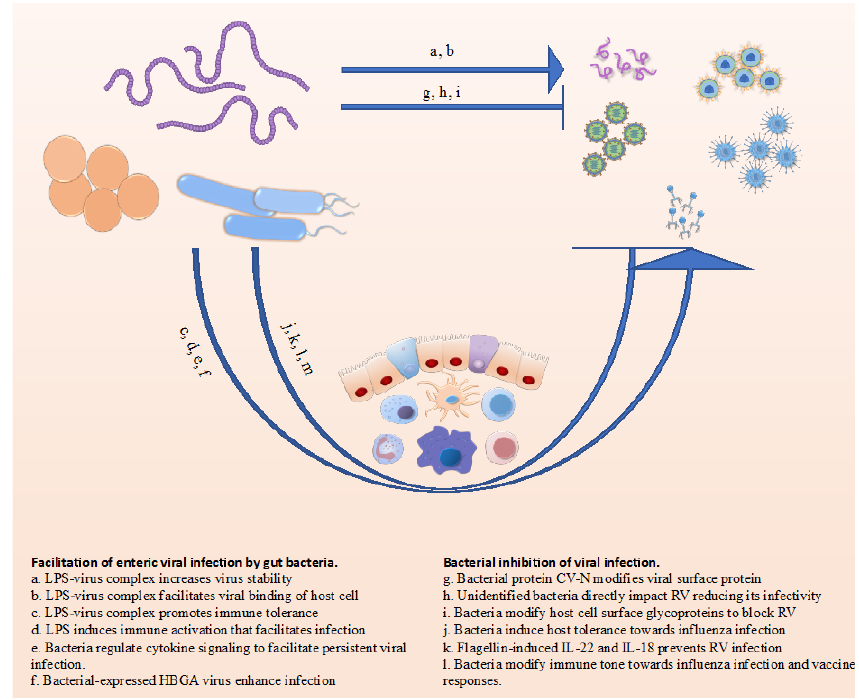
Figure 1. Summary of some of the ways bacteria impact viral infection.